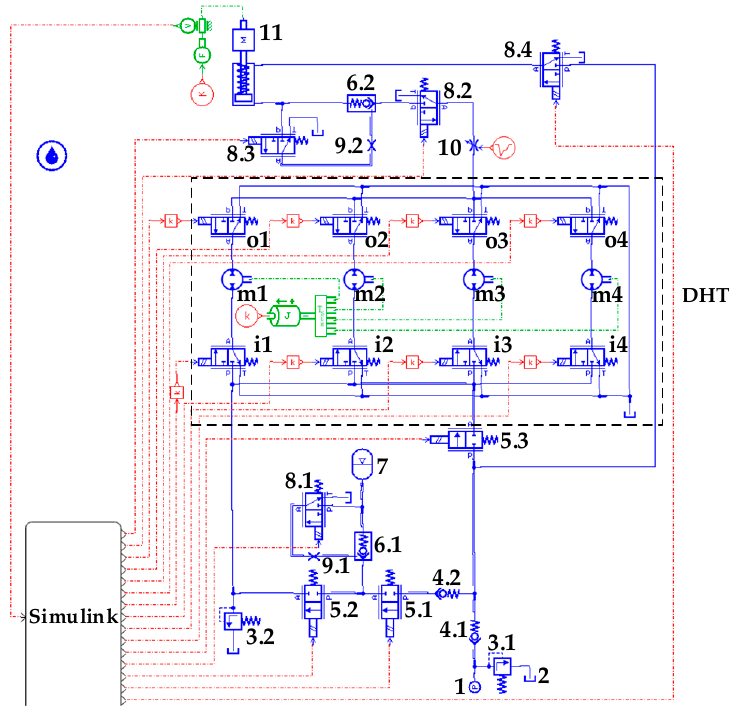
Figure 4. Physical simulation model of the hydraulic circuit of the traction system. (1) Pressure source. (2) Tank. (3) Relief valve. (4) Check valve. (5) Solenoid on/off valve. (6) Hydraulic controlled check valve. (7) Bladder accumulator. (8) Two-position, three-way solenoid